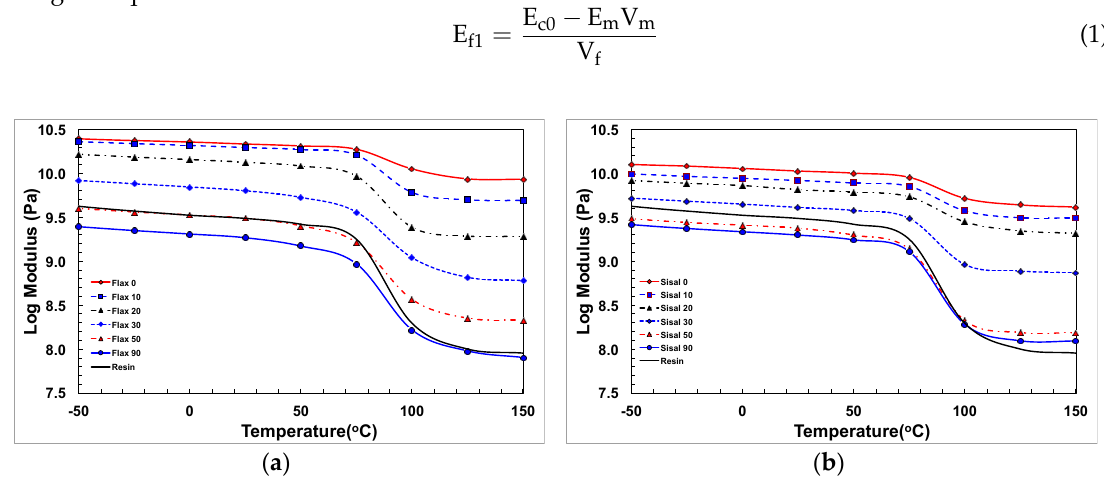
Figure 2. Results of dynamic mechanical analysis (DMA) of epoxy matrix and composites at various loading angles: ( a ) Flax fibre composites; ( b ) Sisal fibre composites.